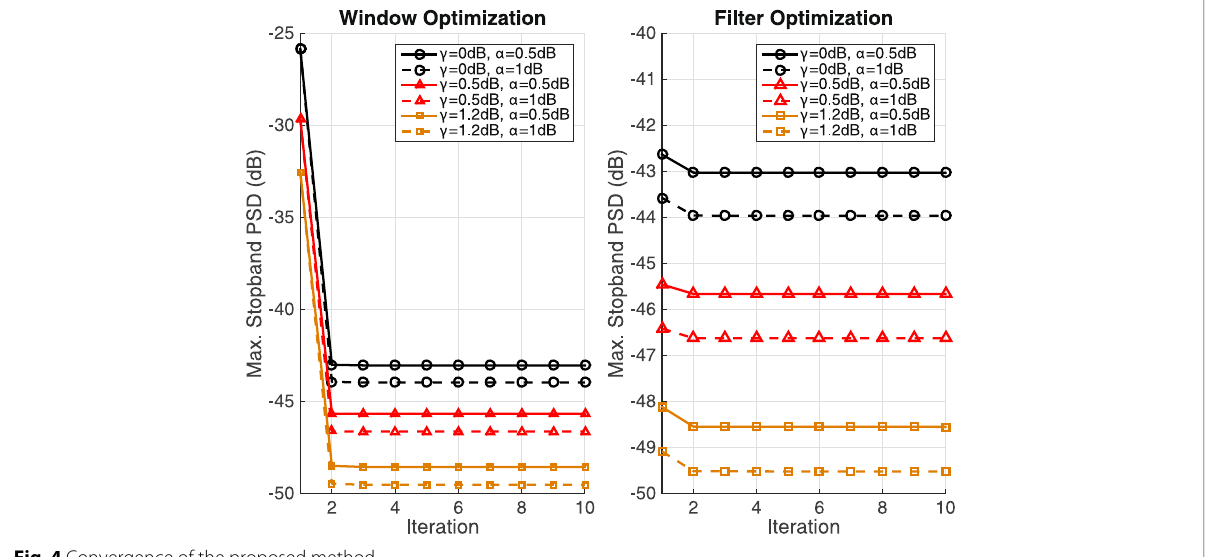
Fig. 4 Convergence of the proposed method